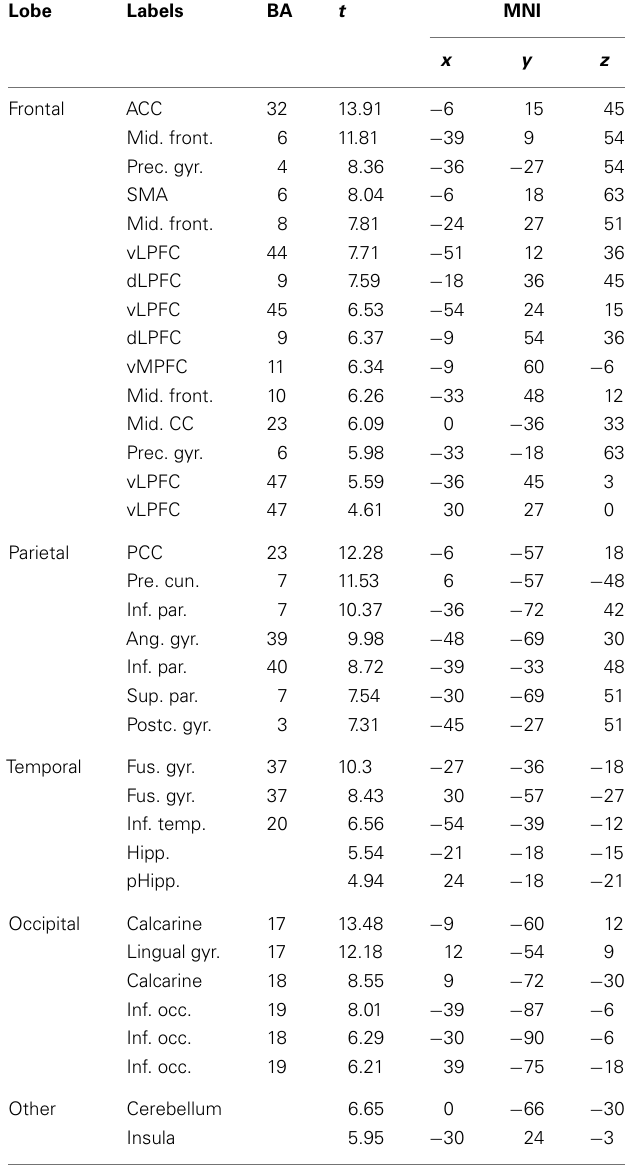
Table 2 | List of regions activated during memory